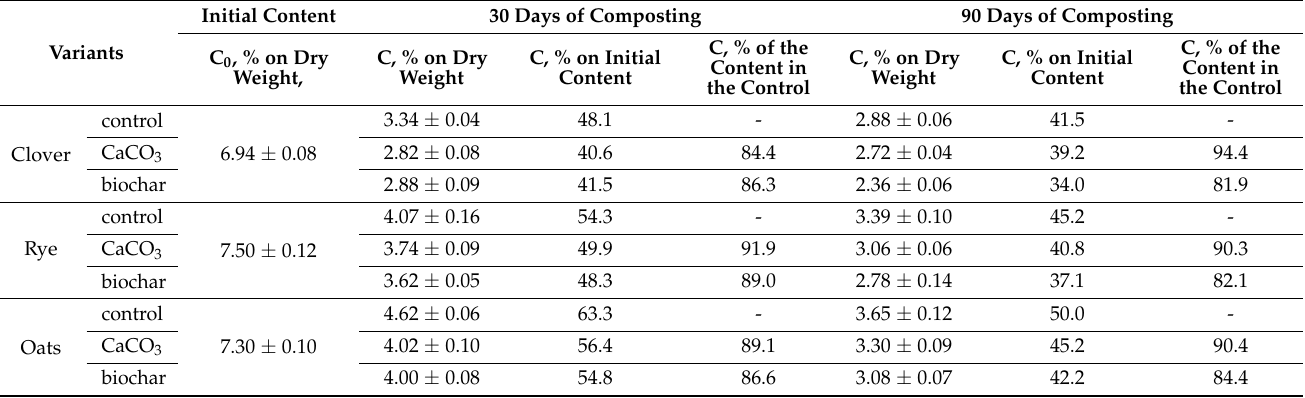
Table 2. Effect of calcium carbonate and biochar on the carbon content of decomposing plant